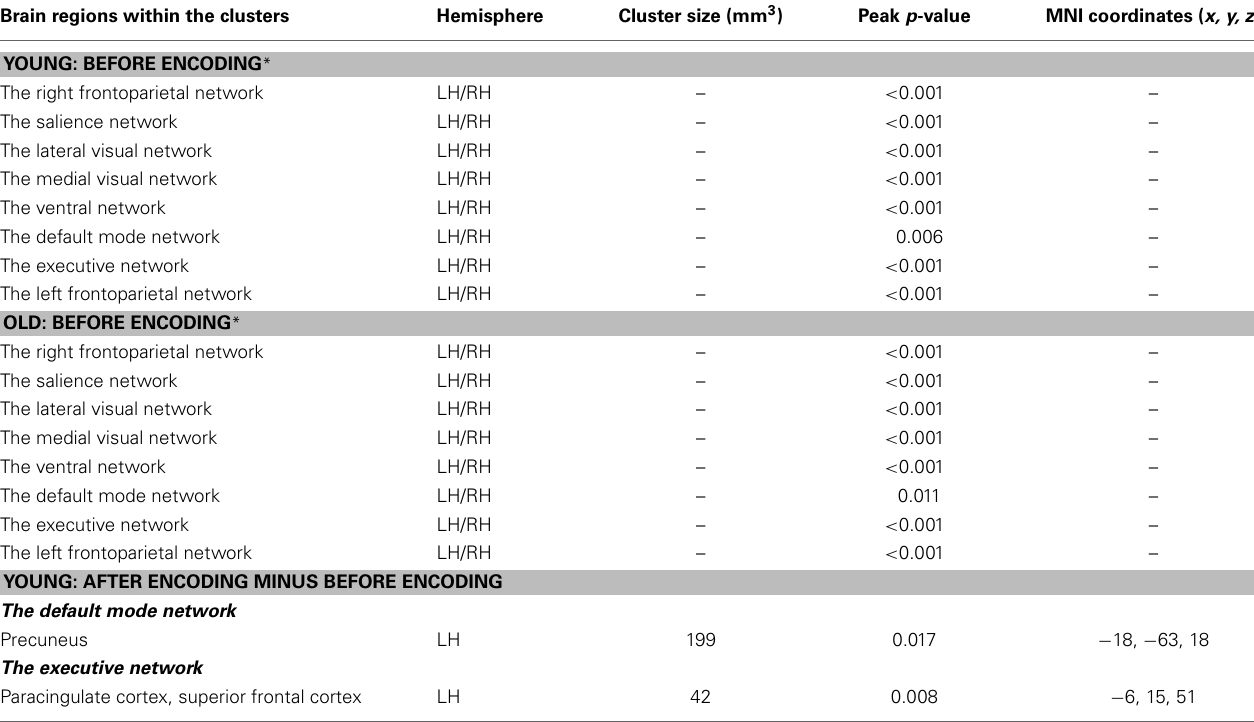
Table 4 | Resting-state connectivity within the networks of interests within the young and older individuals. Brain regions within the